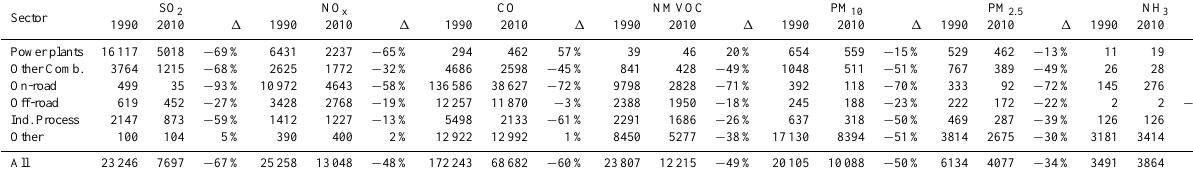
Table 4. Sector-specific emissions in the United States for 1990 and 2010 estimated in this study (unit: Ggyr − 1 ) . Sector